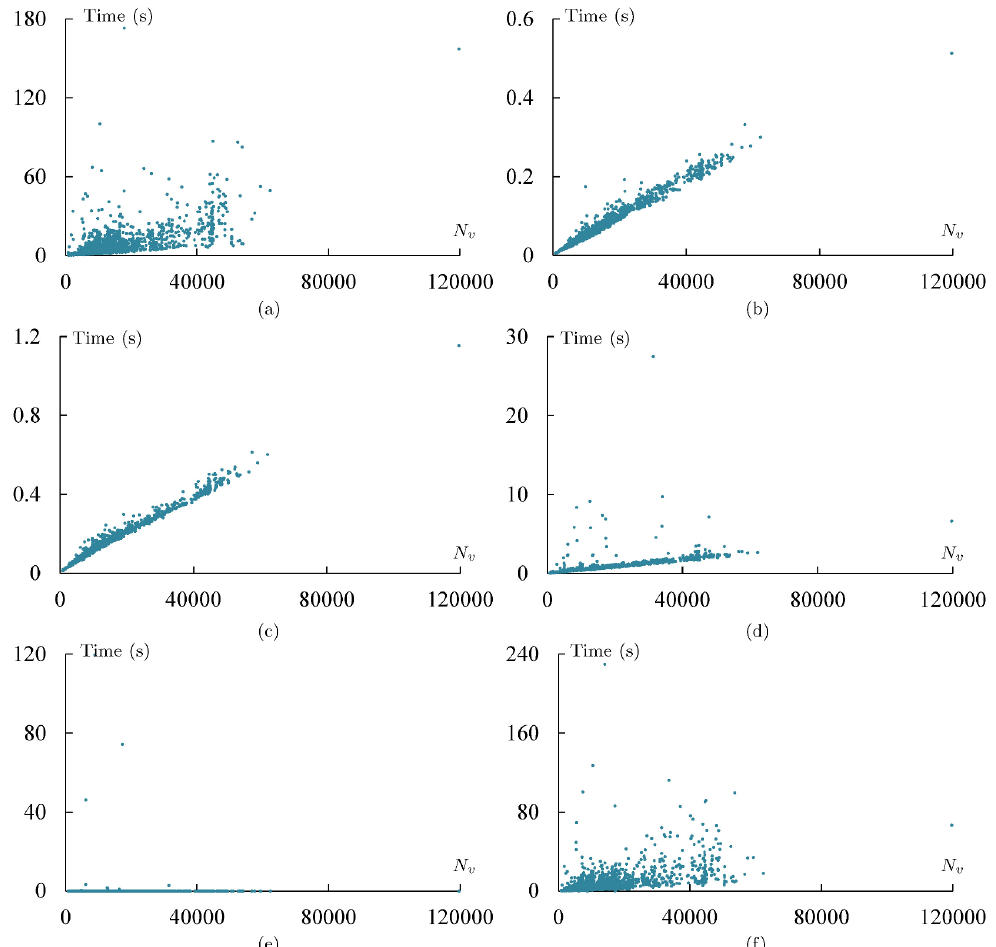
Fig. 12 Timings. The graphs plot the running time (s) vs. the number of vertices N v for each step of our method: (a) generating the initial globally injective parameterization, (b) reducing distances, (c) constructing the scaffold mesh, (d) removing flips, (e) remeshing and removal process, (f) optimizing distortion energy. Each dot represents one mesh. Most meshes do not need to be remeshed, so most dots in (e) take 0